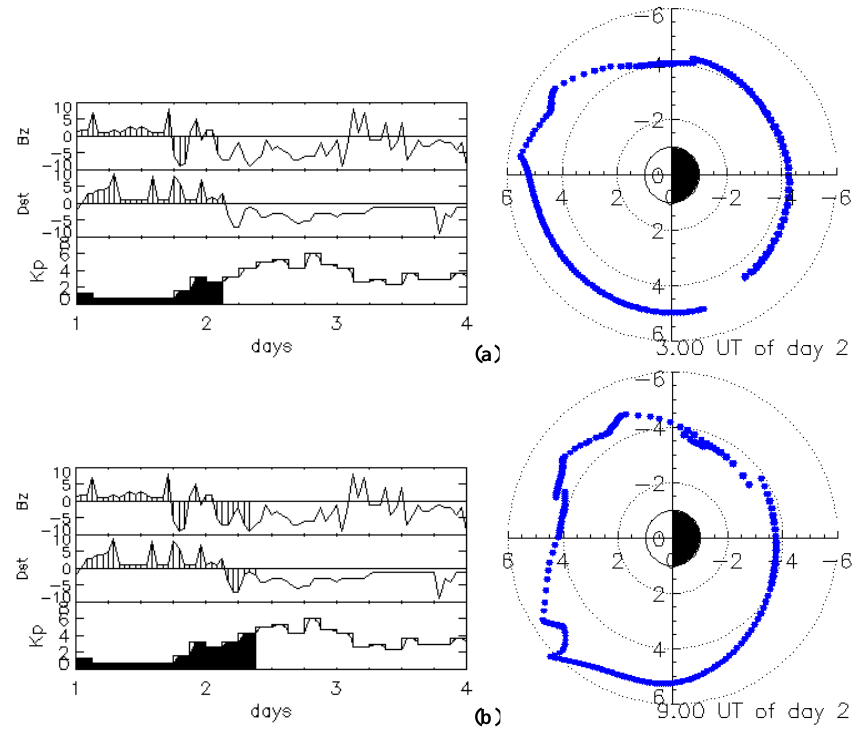
Fig. 9: Simulation of the development of the plume on June 26, 2000 at 3h00 (left panel (a)) and 9h00 (right panel (b)). IMAGE could not give global views of the plasmasphere during this period of time.